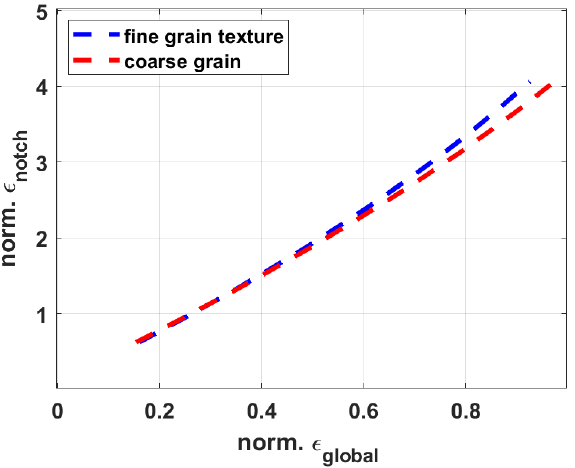
Figure 3. Normalized relationship between the global strain at the extensometer ε global and the local strain at the notch root ε notch for the coarse- and fine-grain textured material.